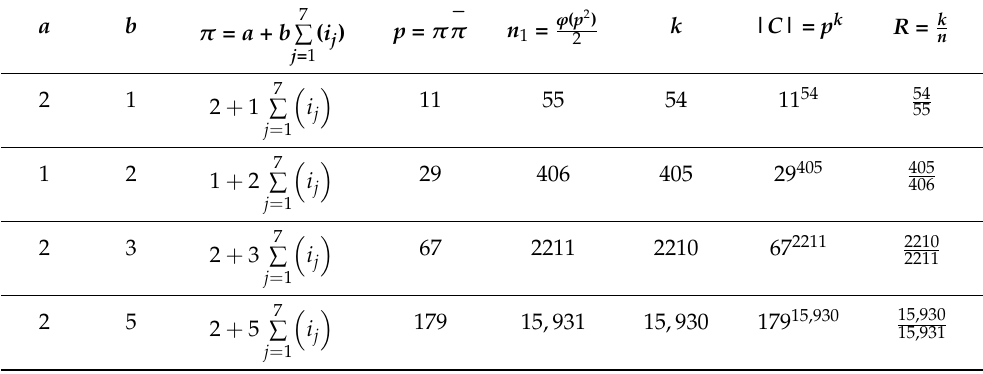
Table 3. Primes, length, cardinality, and code rate (R) of code over octonion